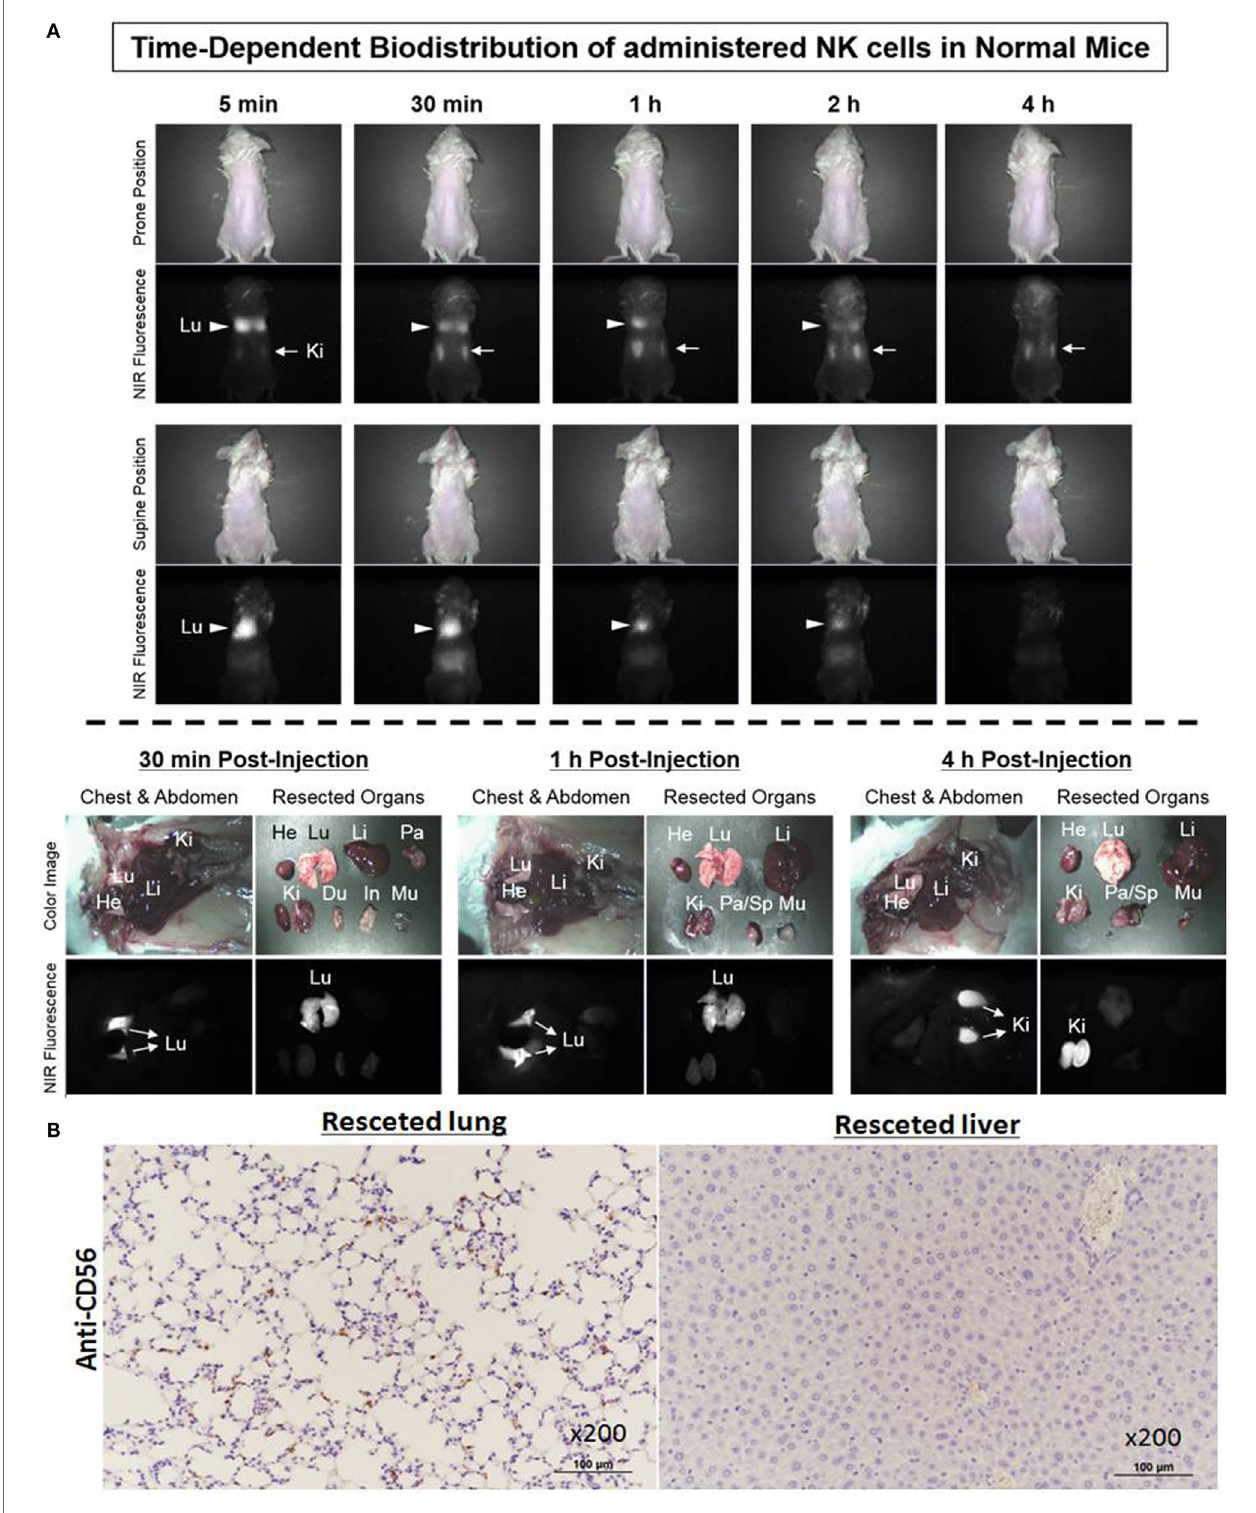
FigUre 5 | Biodistribution of ex vivo -expanded natural killer (NK) cells on non-tumor-bearing NSG mice. NK cells stained with 0.2 µM of ESNF13 dye were injected into normal NSG mice by intravenous routes. (a) The fluorescent signal was detected using a Mini-FLARE near-infrared (NIR) optical imaging system. After various time points, the mice were sacrificed and resected organs were explored. (B) The lung and liver were resected 4 h after injection of ESNF13-staind NK cells, where anti-CD56 was used to detect CD56 + NK cells. CD56 + NK cells were easily identified in the lung but did not populate in the liver.